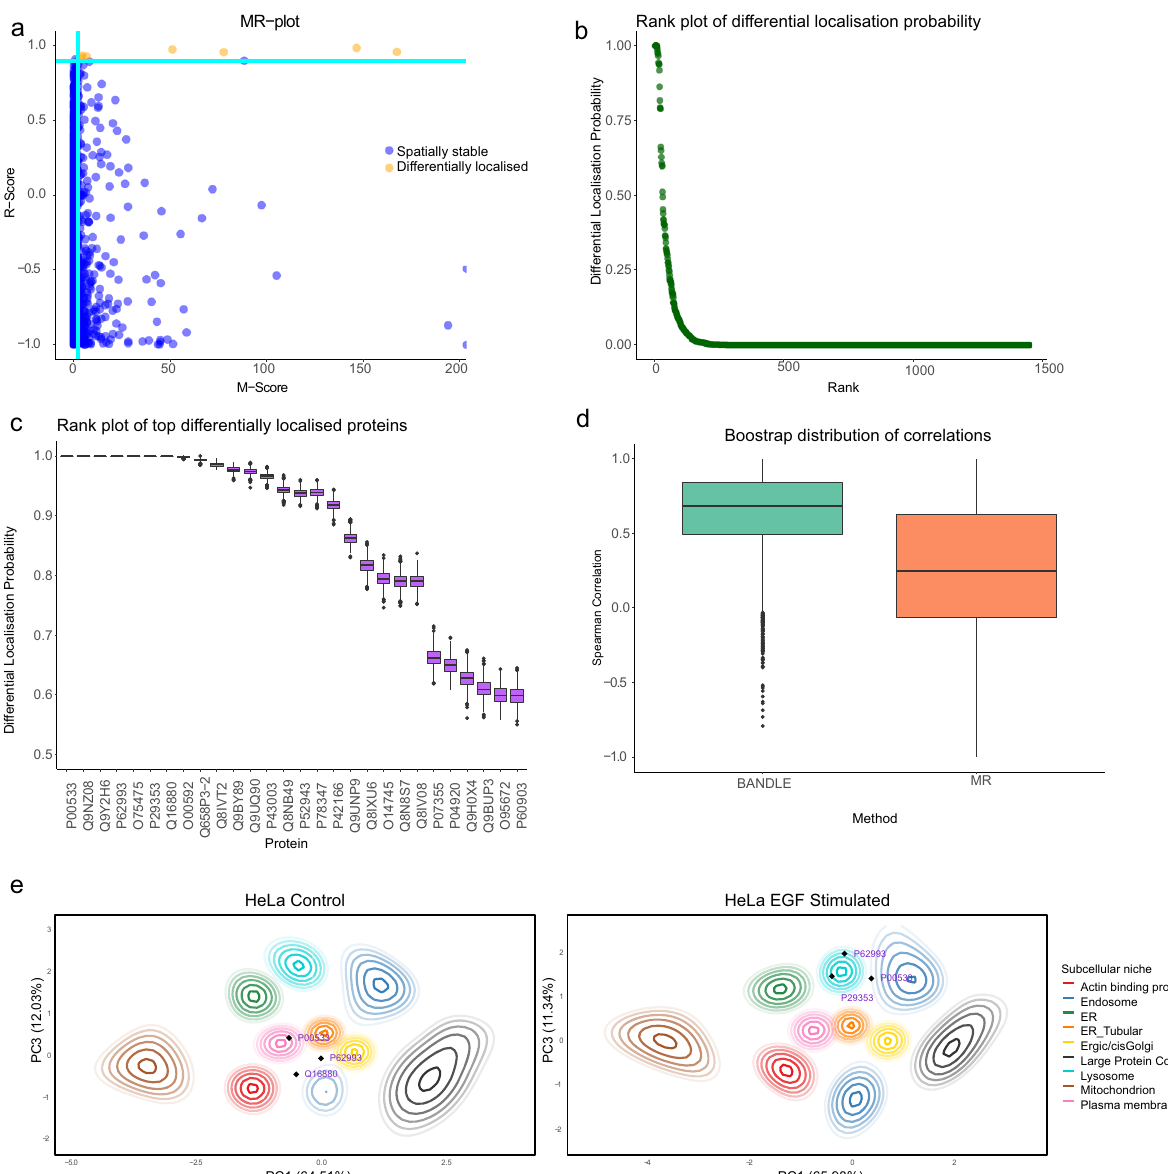
whiskers extending to 1.5*IQR. e PCA plots with (smoothed) localisation prob- abilities project onto them. Each colour represents an organelle and ellipses represent lines of isoprobability. The inner ellipse corresponds to 0.99 and the proceed line 0.95 with further lines decreasing by 0.05 each time. The annotated proteins demonstrate examples of differential localisations. EGFR (P005330) clearly relocalises from the PM to endosome, while SHC-1 (P29353) and GRB2 (P62993) relocalise from unknown localisation to the lysosome. Source data are provided as a Source Data fi le in the Supplementary